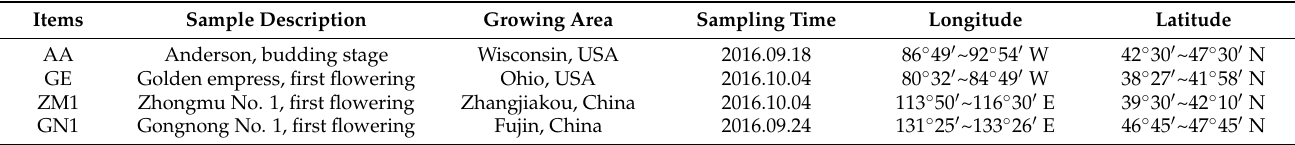
Table 1. Samples